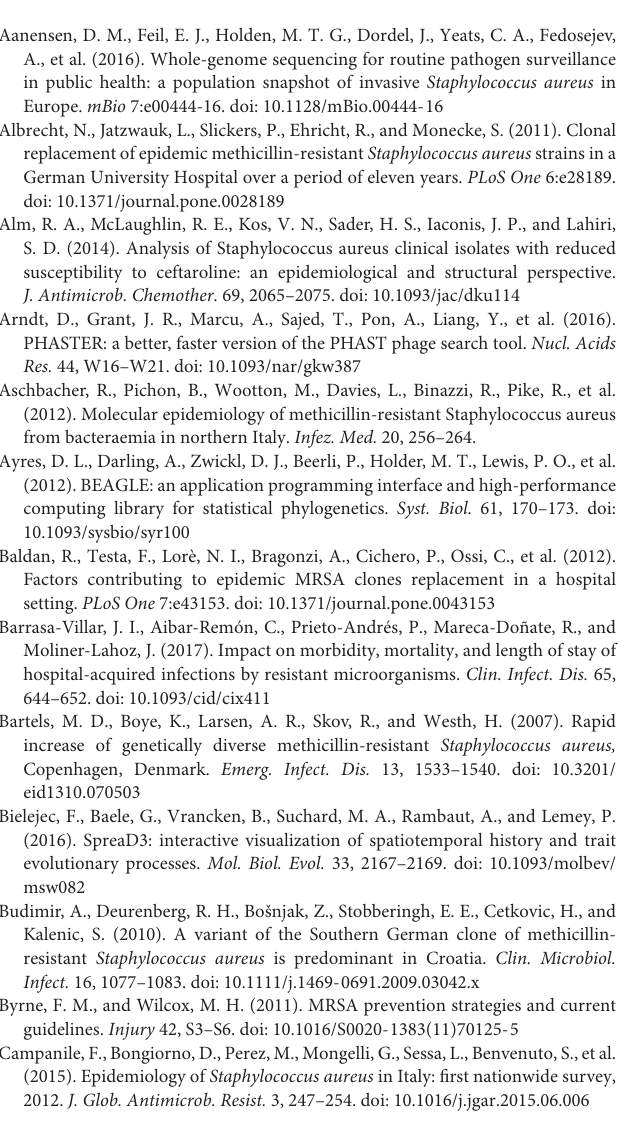
FIGURE S2 | Root-to-tip regression compared to sampling date as estimated by TempEst. (A) Temporal signal in the entire dataset of 530 ST228/ST111 MRSA